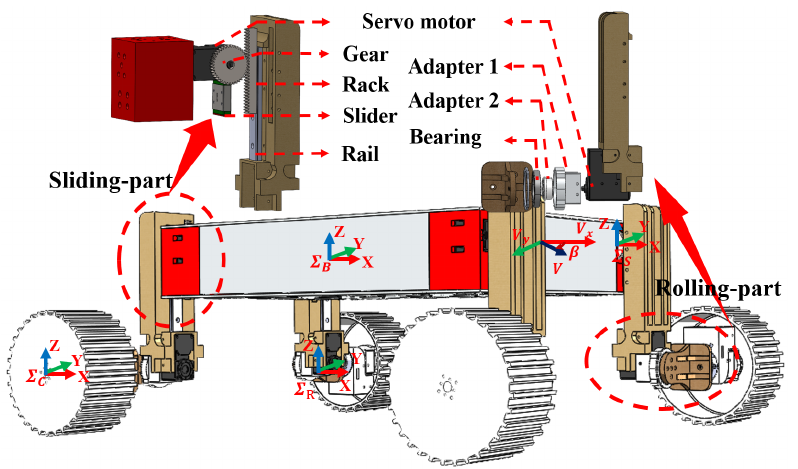
Figure 2. The ROMA-Sloper rover is reconfigurable, and it contains an active two-level adjustment mechanism: sliding-part and rolling-part. The detailed structures of the two parts are shown in the exploded view. Some coordinate systems are attached to this